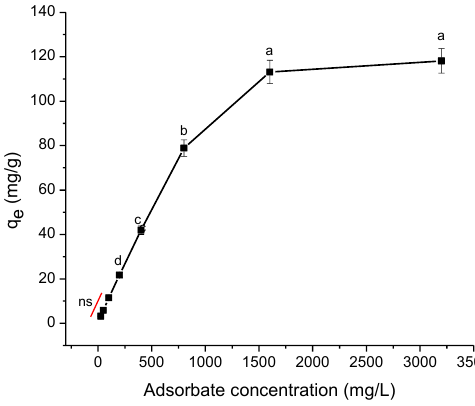
Figure 9. The effect of adsorbate concentration on the sorption of enrofloxacin onto P. koidzumii sorbent (adsorbent dose 8 g/L; contact time 40 min; pH 7; and temperature 298 K). Those means that do not share a common superscript differ significantly (Tukey p < 0.05). ns = not significant.